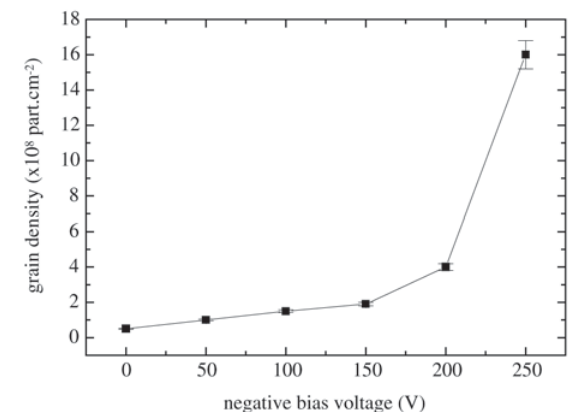
Figure 2. Top view scanning electron micrographs, in the same magnification, for the nucleation on Ti6Al4V substrate using (a) -50; (b) -150; (c) -250 V bias, respectively.